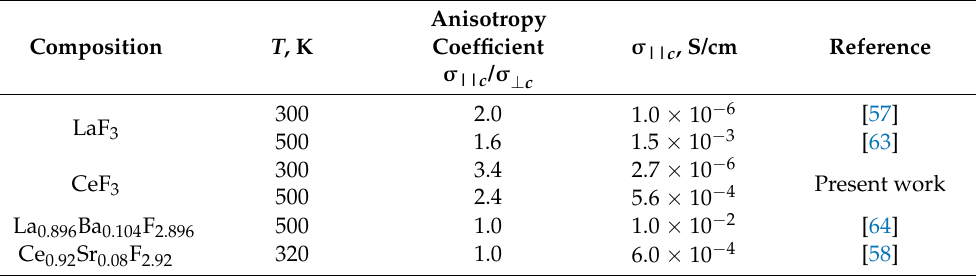
Table 3. The anisotropy of ionic conductivity in selected fluoride crystals with a tysonite-type structure.